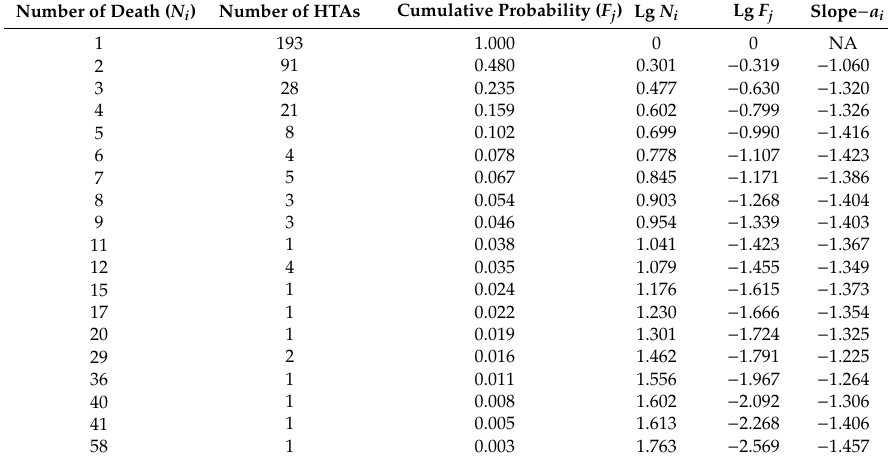
Table 4. The data for the F-N curve under uncertainty.